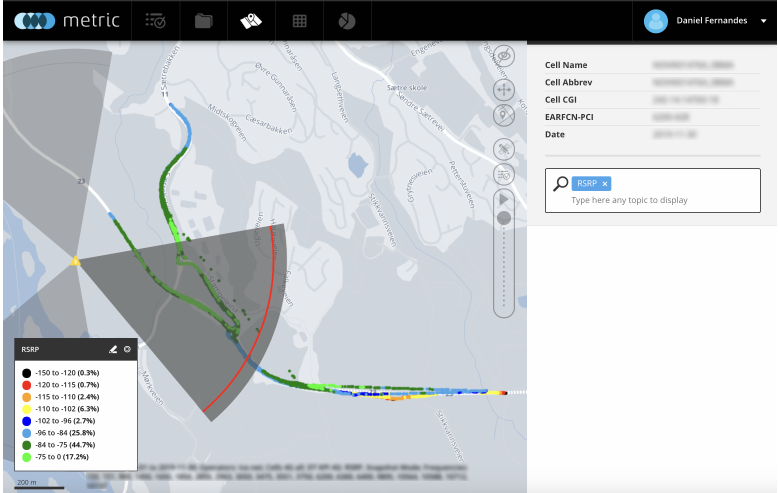
Figure 7. Considered scenario to validate our